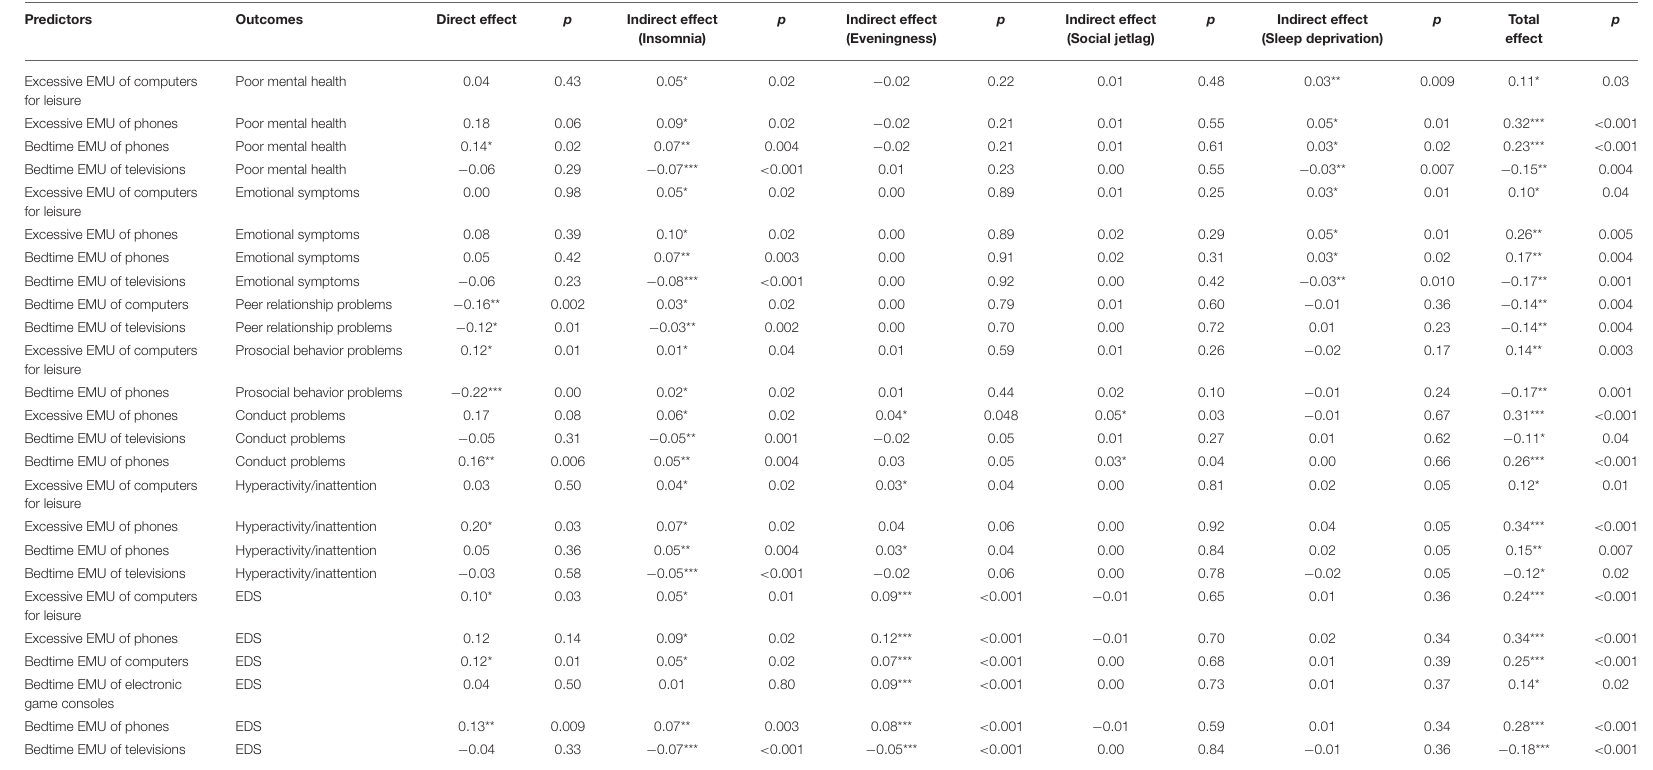
TABLE 5 | The significant effects of sleep and circadian problems in the associations of excessive and bedtime EMU with social, emotional, and behavioral difficulties.